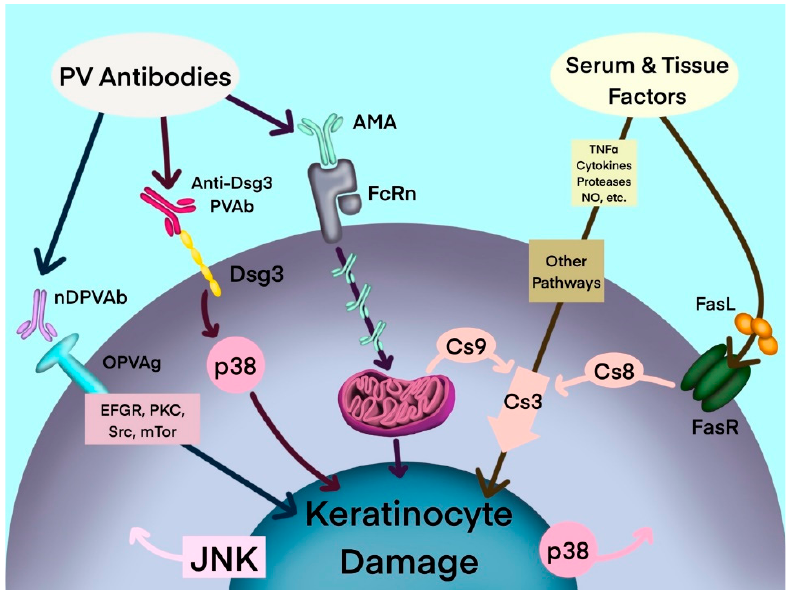
Figure 1. Hypothetical multipathogenic mechanism of interconnected signaling cascades leading to keratinocyte apoptolysis in pemphigus (modified from Marchenko et al. [19]). AMA: antimitochon- drial antibodies; Anti-Dsg3 PVAb: anti-desmoglein 3 PV antibody; Cs: caspase; Dsg3: desmoglein-3; EGFR: epidermal growth factor receptor; FasL: Fas ligand; FasR: Fas receptor; JNK: c-Jun N-terminal kinase; mTOR: mammalian target of rapamycin; NO: nitric oxide; nDPVAb: non-Dsg PV antibodies; OPVAg: other PV antigens; PKC: protein kinase C; PVAb: PV antibody; Src: SRC proto-oncogene, nonreceptor tyrosine kinase; TNF- α : tumor necrosis factor- α .